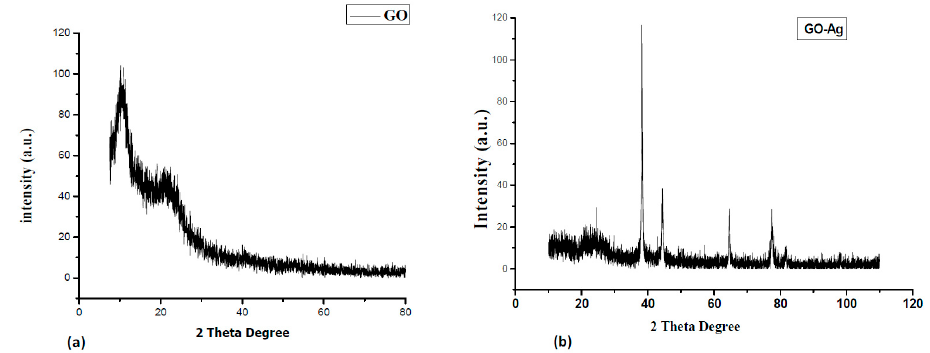
Figure 1. X-Ray diffraction (XRD) structure of ( a ) Graphene Oxide (GO) ( b ) Graphene Oxide-silver (GO-Ag) nanocomposites.